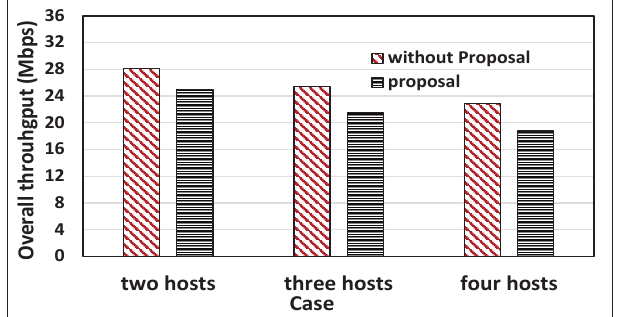
Figure 17. Total throughput comparisons for with and without a proposal for web